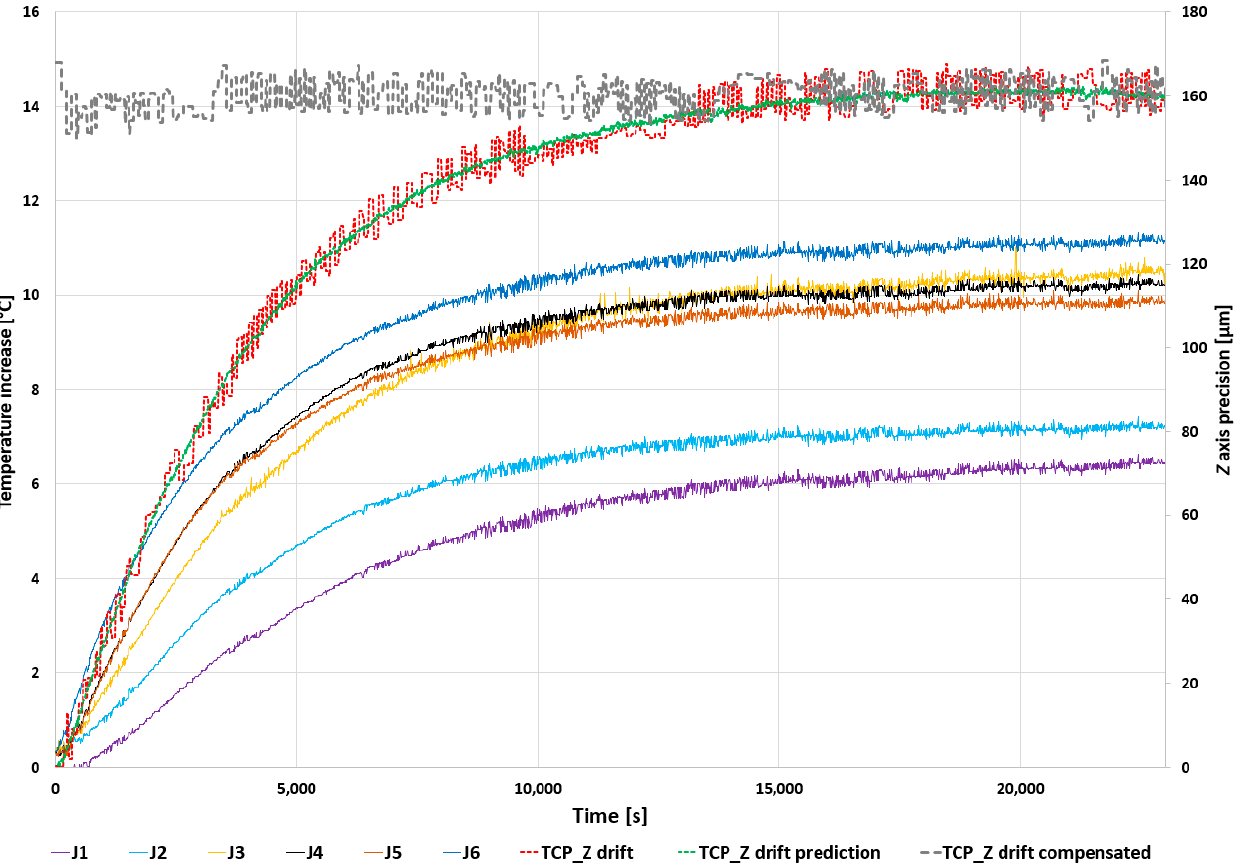
Figure 9. With and without drift compensation, Target 1, working speed. Data recorded during the initial measurement: purple—joint 1 temperature, light blue—joint 2 temperature, yellow—joint 3 temperature, black—joint 4 temperature, orange—joint 5 temperature, dark blue—joint 6 temperature, red dots express the uncompensated TCP Z-axis drift, green dots—TCP Z drift prediction based on MatLab regression learner, grey trend represents the TCP Z drift with drift compensation applied.